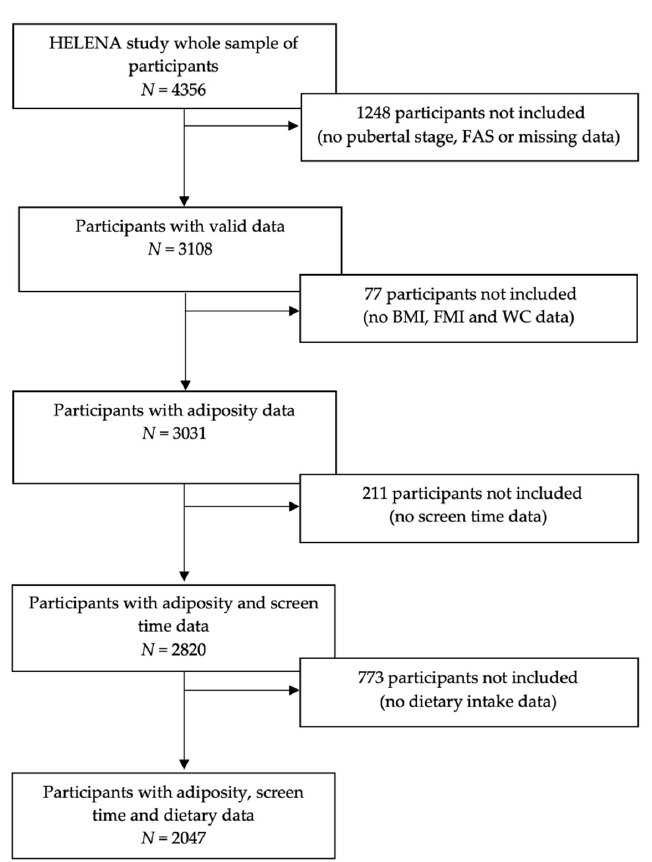
Figure 1. Flow chart of the sample selection process. Abbreviations: FAS, family affluence scale; BMI, body mass index; FMI, fat mass index and WC, waist circumference.